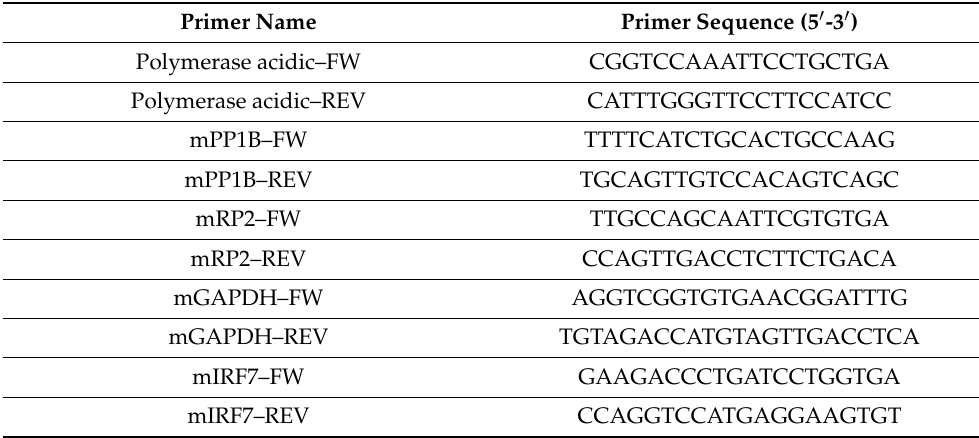
Table 1. List of qPCR primers for RT-qPCR analysis in this